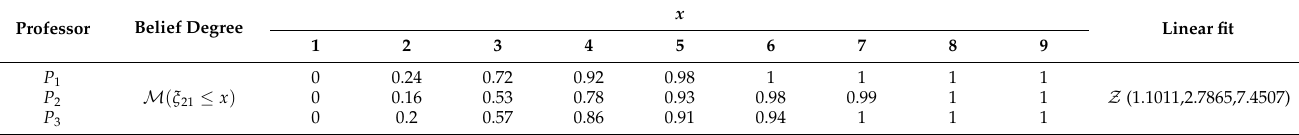
Table 4. The collated data for criteria C 1 and C 2 .